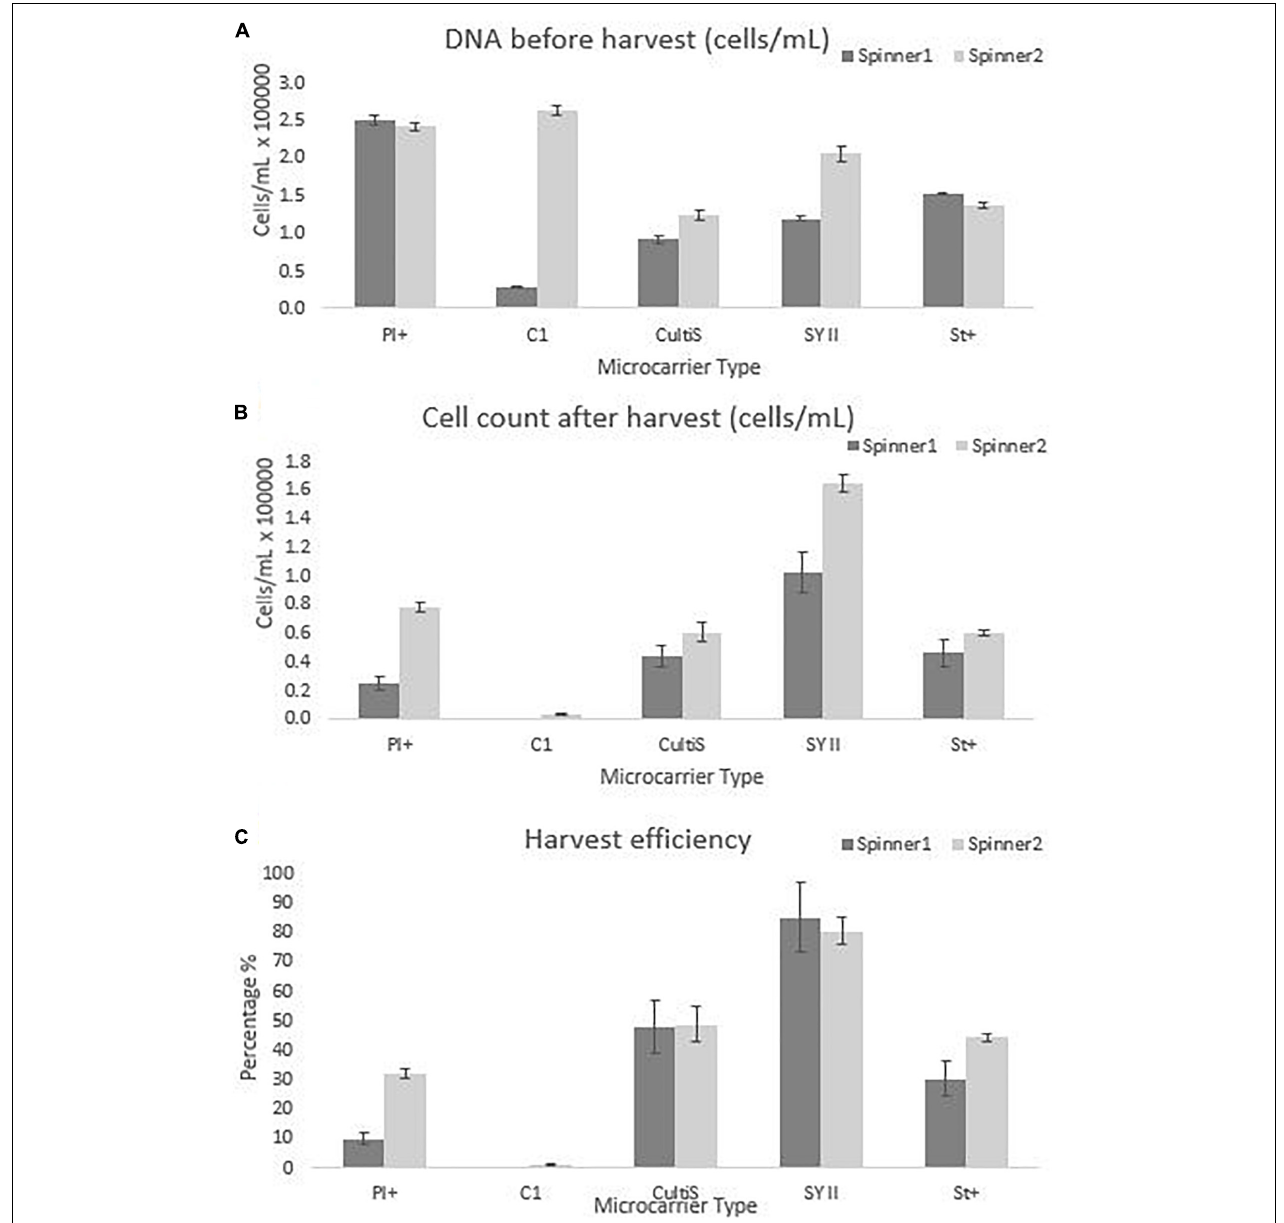
FIGURE 6 | Cell quantity observations for the dynamic screening experiments of the microcarriers Star-Plus, SynthemaxII dissolvable, Plastic-Plus, Cytodex1, and Cultispher-S. The experiments were performed in duplicates for each of the microcarriers. (A) The DNA amount of the cells attached to the microcarriers on day 8 before harvest was measured and converted to a cell quantity. (B) The cells after harvest were measured for each spinner flask and (C) the harvest efficiency was calculated based on the comparison of the cells before harvest with the cells after harvest.